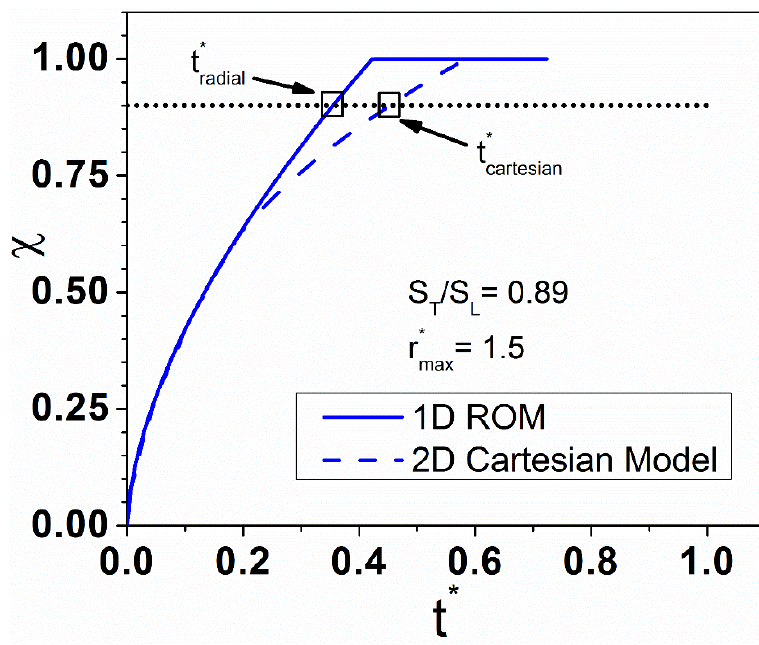
Figure 10. Graph of 𝜒 vs. 𝑡 ∗ for the 1D ROM and 2D CFD Cartesian models.